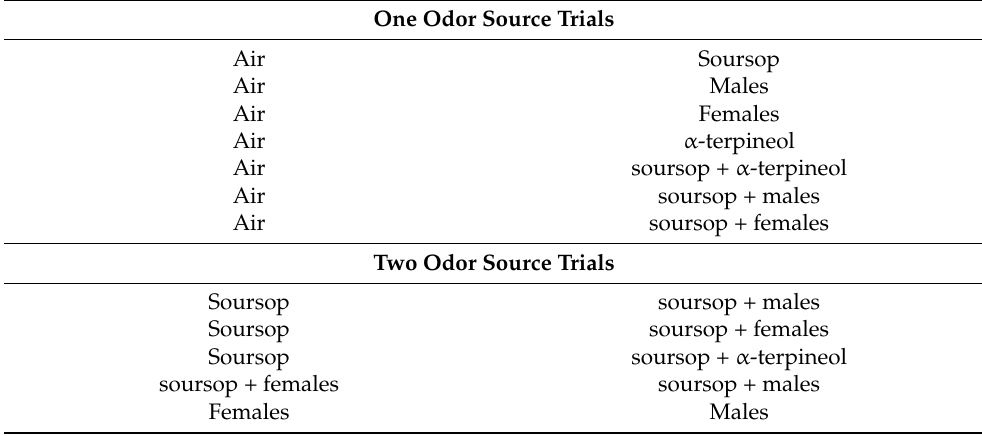
Table 1. Odor source combinations used in olfactometry assays. For all bioassays, when the odor source required it, 2 g of soursop were used. All male and female groups contained 20 specimens. For combinations including α -terpineol, 100 µ L of a 4 ng/ µ L solution were